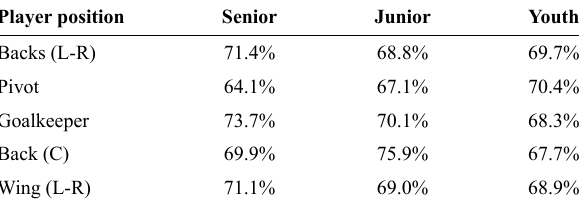
Table 6 - Discrimination ability of the player height on the ranking of the teams, grouped as the first eight versus the rest of the teams, expressed as the proportion (%) of correctly classified